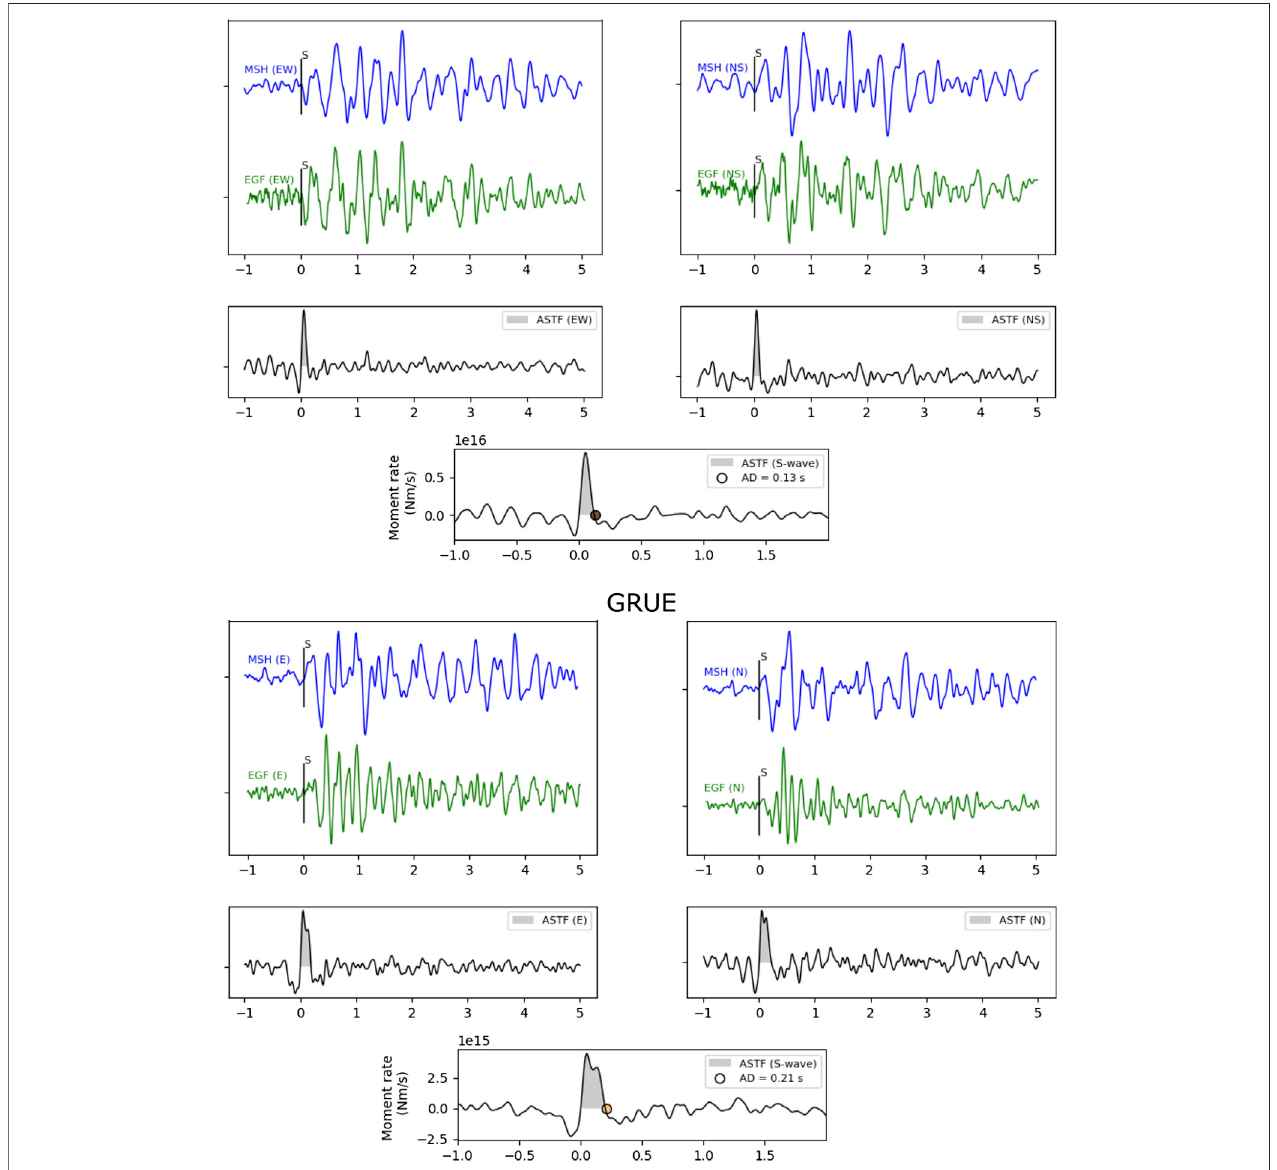
FIGURE 3 | Frequency-domain deconvolution results for the seismic stations TITE (top panel) and GRUE (bottom panel) using S-wave windows for the East (E) component (left side) and North (N) component (right side) . Each panel shows original seismograms from the mainshock (MSH, blue lines), the empirical Green ’ s function (EGF, green lines); the calculated Apparent Source Time Function (ASTF), with a water level value of 0.01 (black lines). Final ASTF from stacking of the results from E and N components are shown in the lower center of each panel, indicating the apparent duration (AP, circles) and moment rate (grey area). S-phase is indicated by vertical bars in the original seismograms. Horizontal axis is in